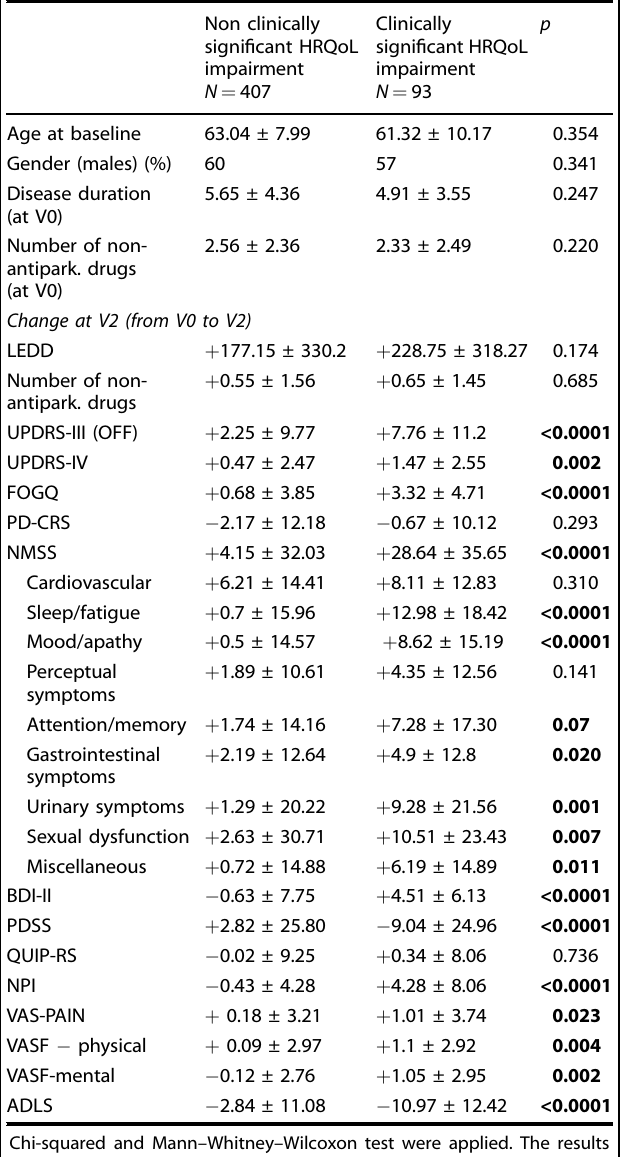
Table 2. Changes in motor and non-motor symptoms and disability in PD patients from V0 (baseline) to V2 (2 years ± 1 month) with regards to presenting or not clinically signi fi cant HRQoL